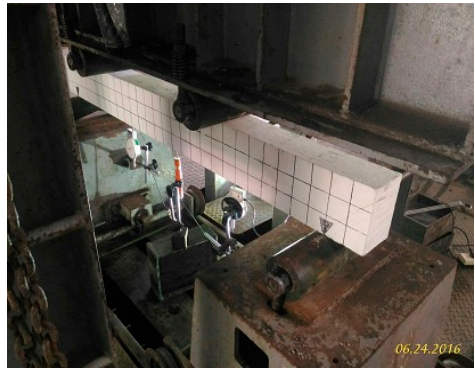
Figure 5. Loading test arrangement.